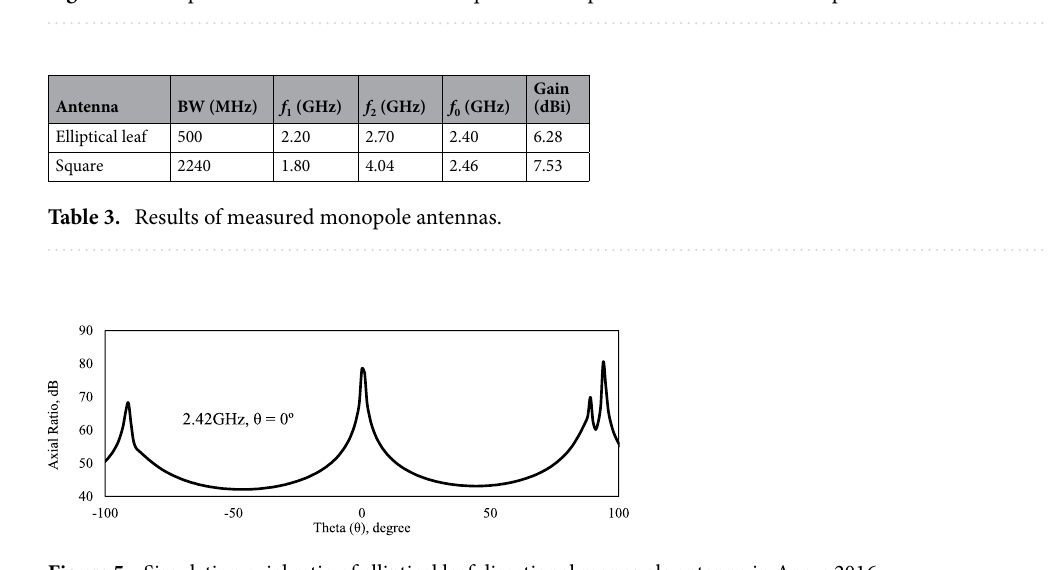
Figure 5. Simulation axial ratio of elliptical leaf directional monopole antenna in Ansys